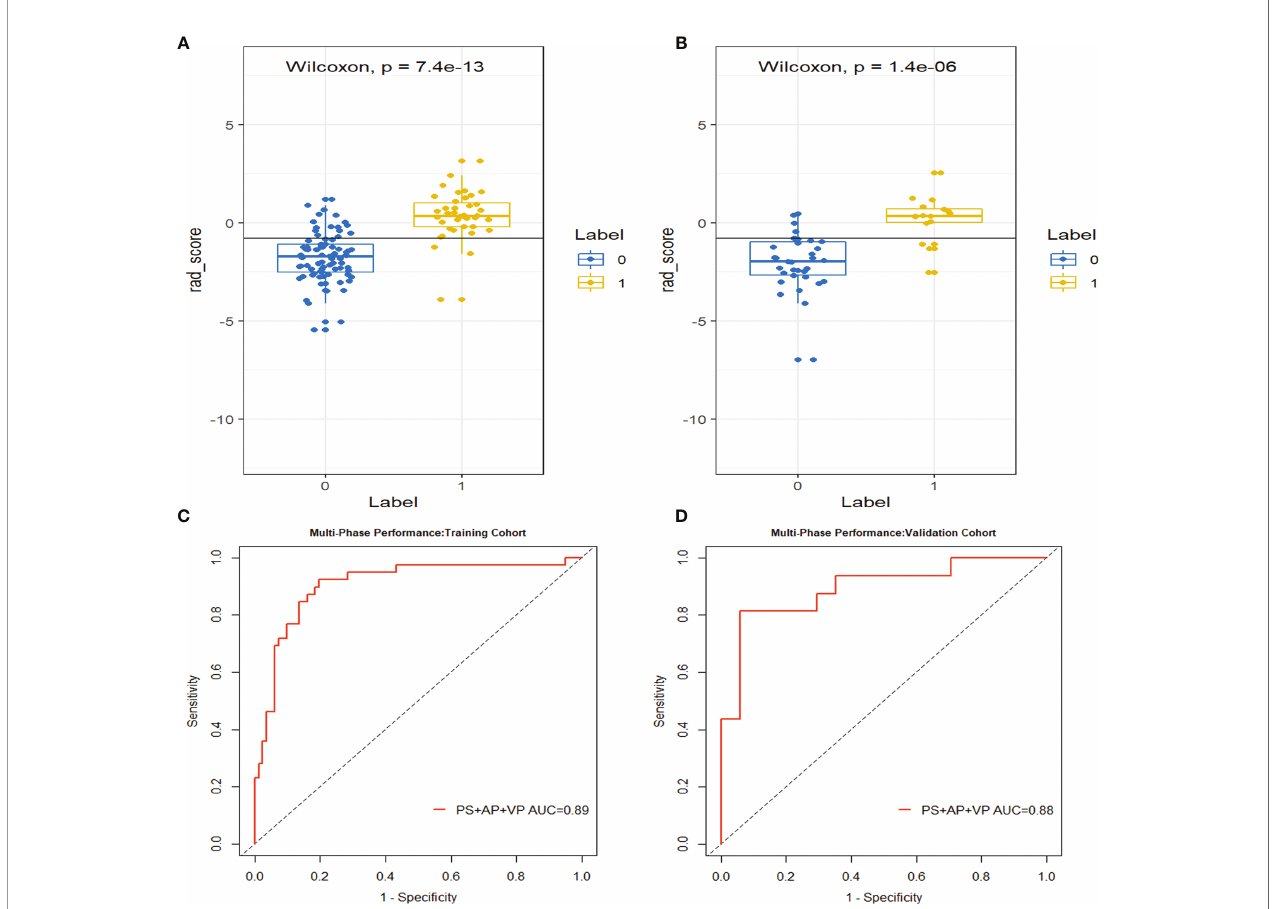
FIGURE 4 | The box-dot plots of the multi-phase radiomics model in the training cohort (A) and the validation cohort (B) . The orange markers indicate patients with MCN while the blue markers indicate patients with SCN. The ROC curves for the multi-phase radiomics model in the training cohort (C) and the validation cohort (D)